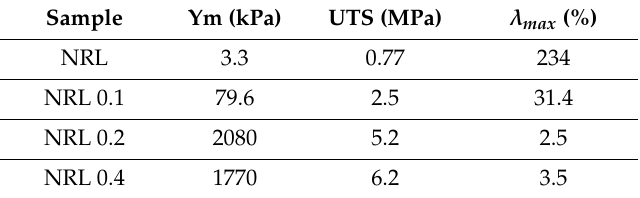
Table 2. Young’s modulus (Ym), ultimate tensile strength (UTS), and maximum elongation ( λ max ). Each value is the average of three replicates samples. NRL—pure natural rubber latex, NRL